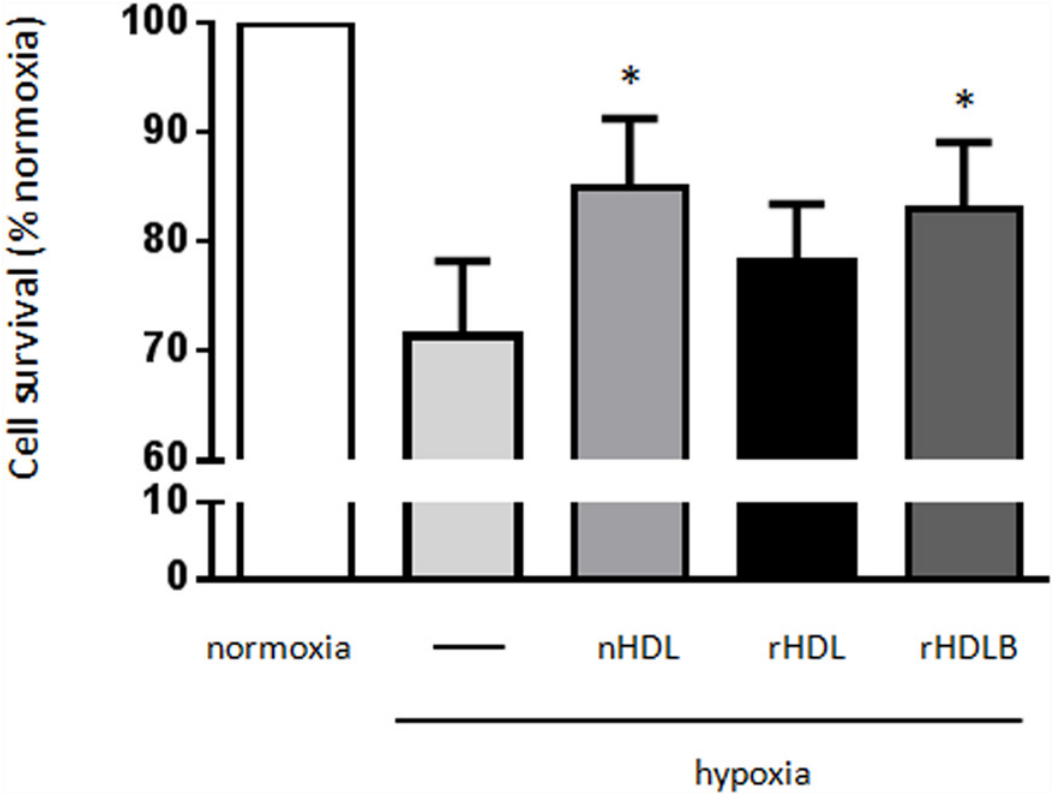
Fig 2. rHDL containing S1P protect against hypoxia in vitro . Cardiomyocytes were incubated in Tyrode solution, submitted to 5h hypoxia and treated during hypoxia with native HDL (nHDL), rHDL (apoAI+POPC) or rHDLB (apoAI + POPC + S1P). Cell survival was determined using the MTT assay. Cell survival is expressed in percentage of normoxia (mean ± SEM). * p < 0.05 vs hypoxia, using paired-student t-test, n = 6.